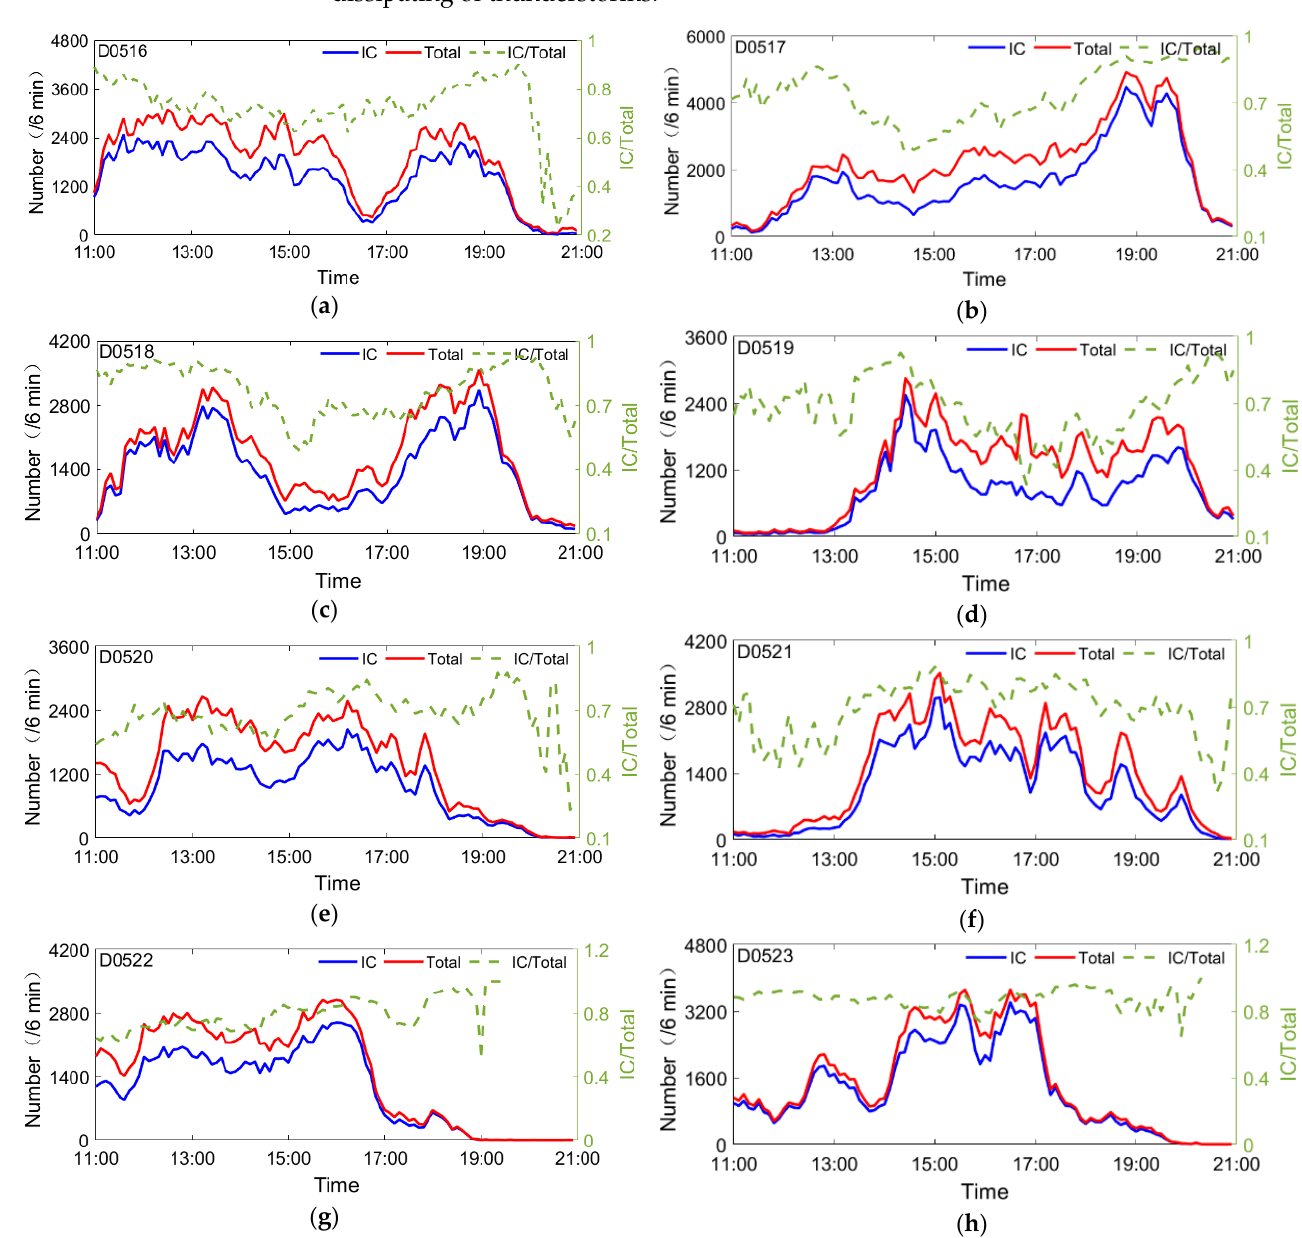
Figure 2. Measured total lightning data for eight days: ( a – h ) Time series of total lightning, IC events and the ratio of IC/Total Lightning. The red and blue solid lines represent the numbers of total lightning and IC events, respectively, while the green dot line represents the ratio of IC events to total lightning. The label in the upper left corner is the date of the thunderstorm.